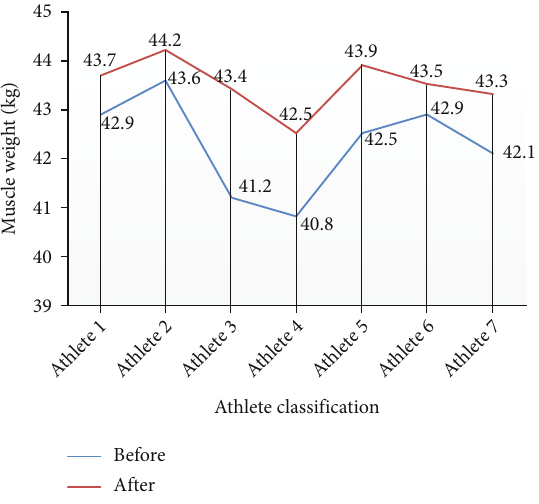
Figure 6: Changes in Muscle Weight in Athletes.